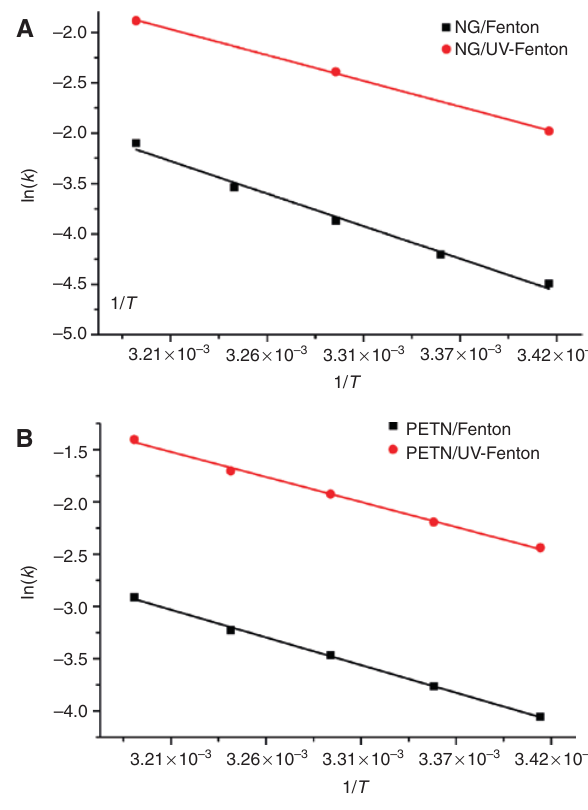
Figure 7: Effects of temperature on the degradation of (A) NG and (B) PETN using Fenton and UV-Fenton.